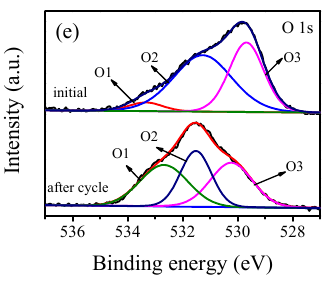
Figure 2. XPS spectra of 4 wt % Pt/Bi 2 MoO 6 (nitric acid method, pH = 9, 180 °C) before and after cycling: ( a ) full spectrum, ( b ) Pt 4f, ( c ) Bi 4f, ( d ) Mo 3d, and ( e ) O 1s.